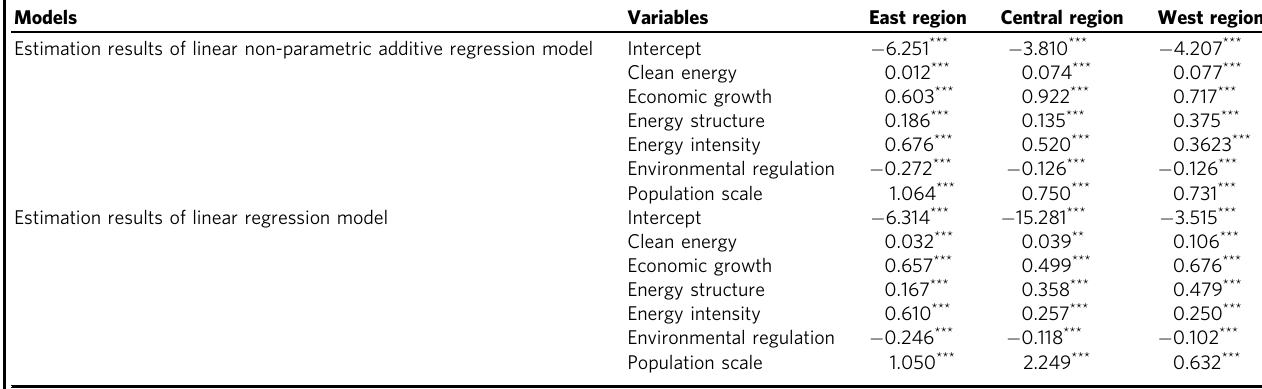
Table 3 The linear impact of CED on regional CDE. Models